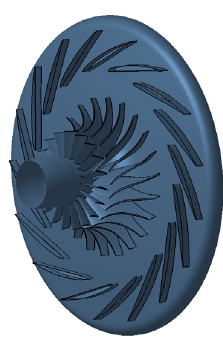
Figure 3. Structure of a MW level gas turbine.